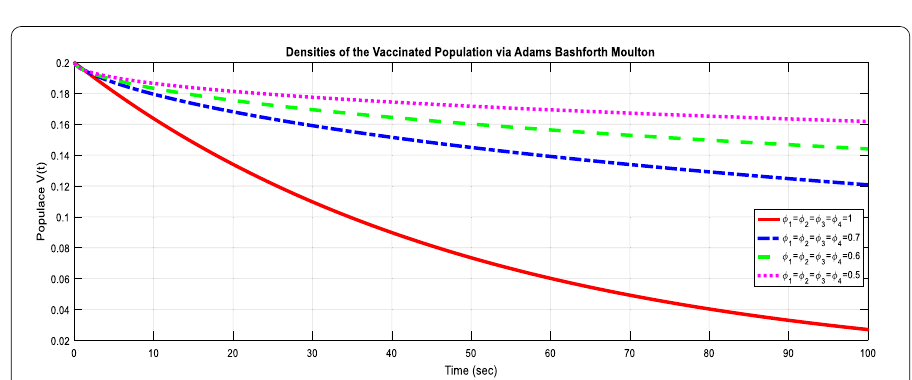
Figure 32 Dynamic of populace V ( t ) by varying the value of